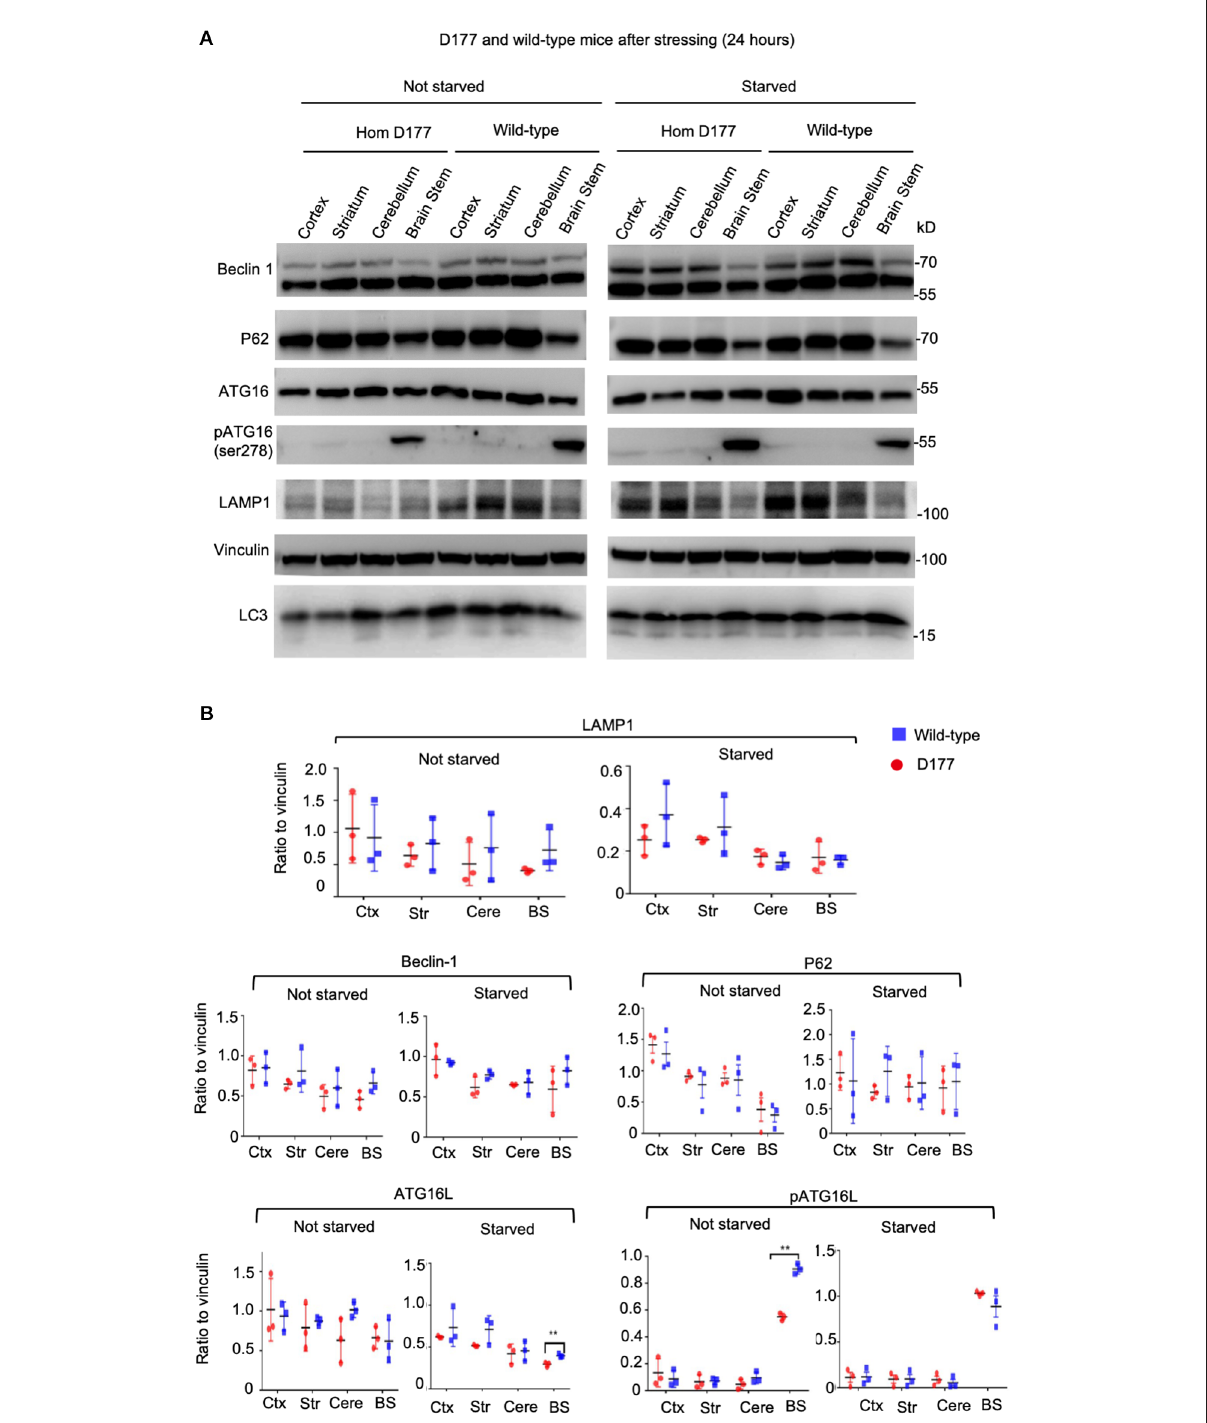
FIGURE3 The expression of autophagy related proteins in D177 homozygous and wild-type mice that were not stressed or stressed by food restriction for 24 h. (A) Western blotting of autophagy related proteins, Beclin-1, P62, ATG16L, phospho-ATG16L, and LAMP1 in D177 homozygous and wild-type mice with and without stressed by food restriction for 24 h. (B) Relative autophagy related protein expression in D177 homozygous and wild-type mice with and without fasting. The values are the ratios of detected protein to the loading control vinculin and were obtained using ImageJ, n = 3 mice, df = 4, ** P < 0.01. Data were analyzed by GraphPad Prism 7.04 and are presented as men ± SEM. Multiple Student’s t -test was used for statistical analysis. p62/SQSTM1, sequestosome 1; ATG16L1, Autophagy Related 16 Like 1; LAMP1, lysosomal associated membrane protein 1; GAPDH, glyceraldehyde-3-phosphate dehydrogenase; Ctx, cortex; Str, striatum; Cere, cerebellum; BS, brain